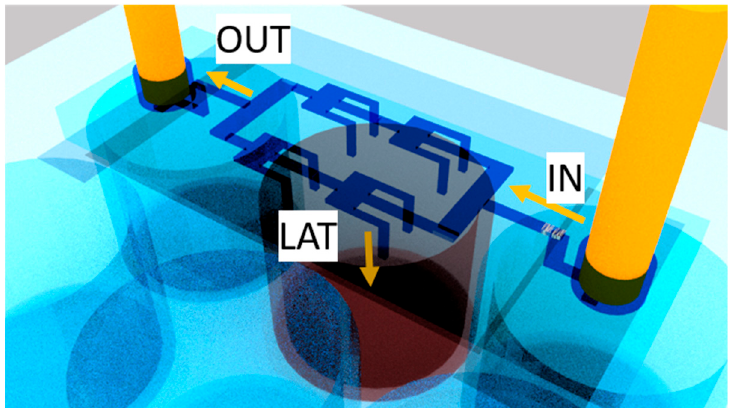
Figure 11. 3D sorting Lab on a Chip developed by Volpe et al. [75] on PMMA through fs-laser technology. The particles exiting through the lateral outlets (LAT) are collected in a multi-well plate, while the others flow through the main exit OUT. The ratio between the resistance of the LAT and the OUT is 20. The channels are 60 μ m high and 50 μ m wide. The chamber’s dimensions are 460 μ m × 540 μ m. Adapted from